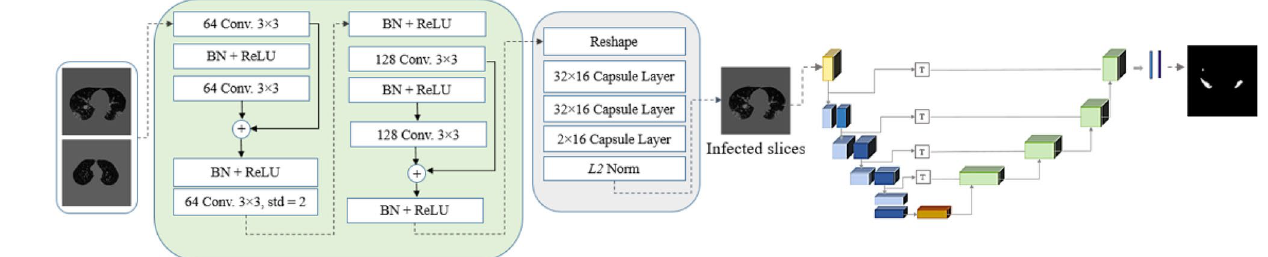
Figure 14. The structure of the Capsule-network-based classifier integrated with the COVID-Rate segmentation